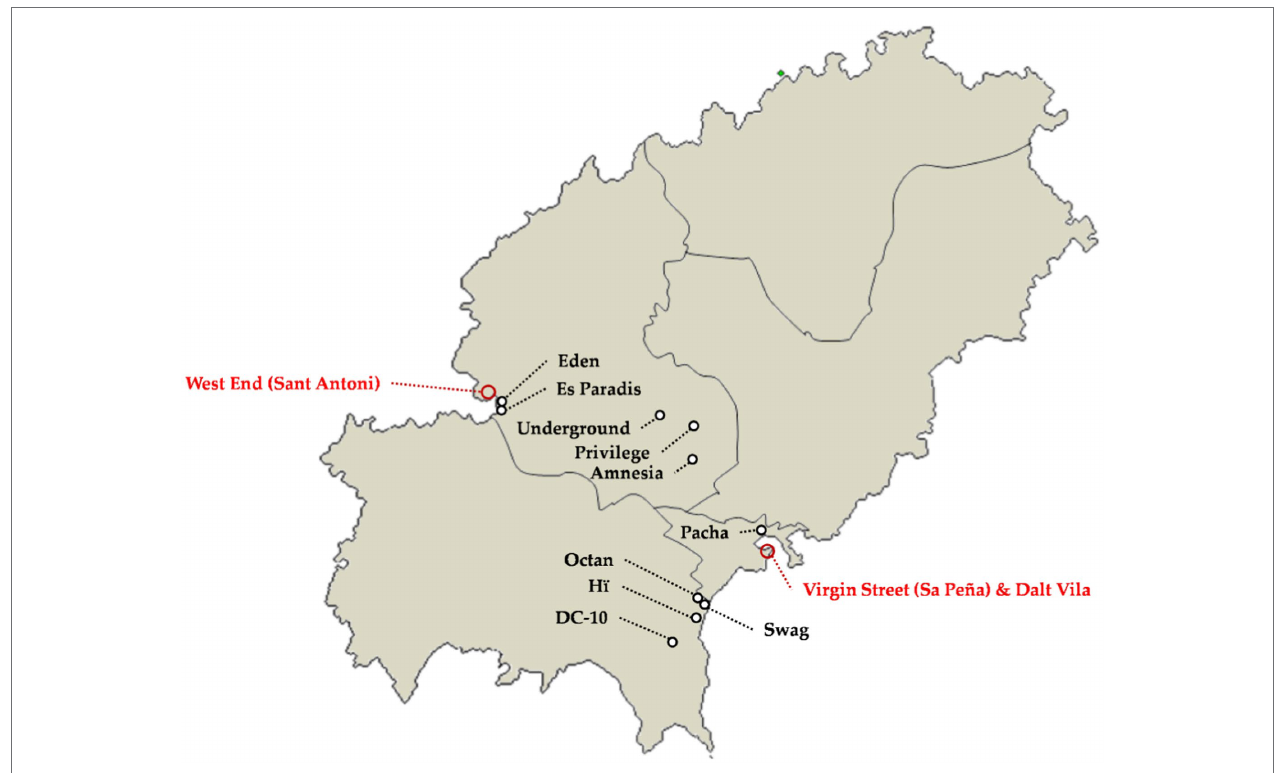
FIGURE 3 | Macro-nightclubs and areas with Conventional nightclubs. Source: own